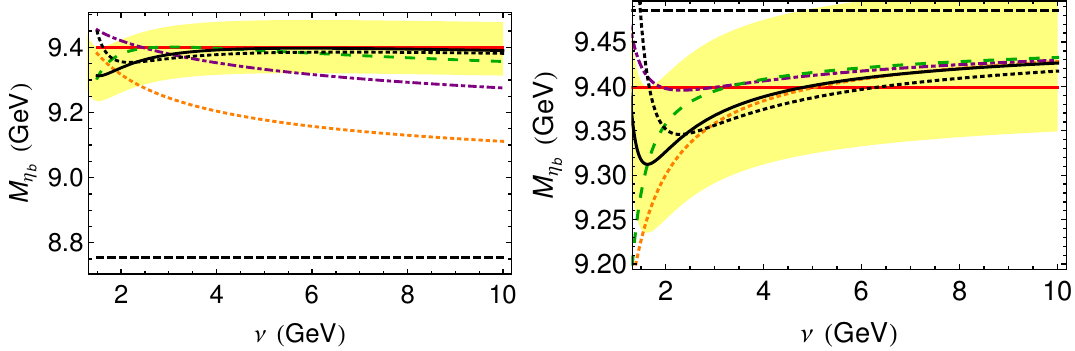
( m b ) GeV, m b; RS 0 = 4 : 743 (cid:0) 41 ( m b ) GeV. +41 +41 . Orange dotted, purple dot- b; RS = RS 0 . The yellow band corresponds to the 10 in RS scheme. Right b